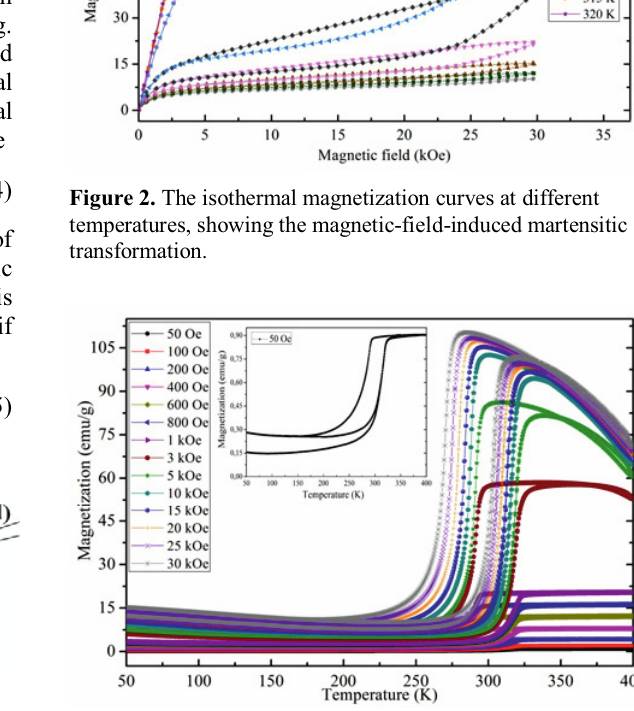
Figure 3. Thermo-magnetization curves at different fields, showing the shift of the martensitic transformation under applied magnetic